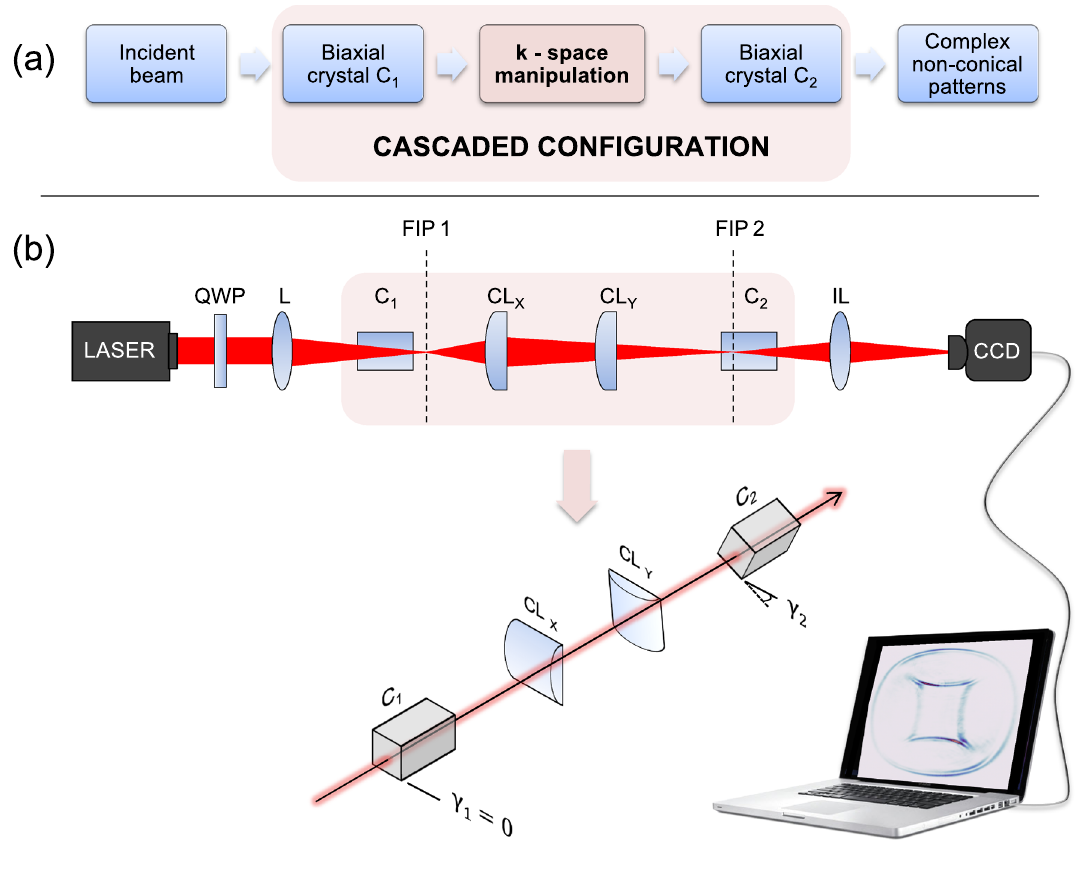
Figure 1. ( a ) Schematic concept for generating non-circularly shaped conical diffraction beams. ( b ) Optical setup; QWP: quarter-wave plate, L: focusing lens, C 1 /C 2 : biaxial crystals, CL x /CL y : crossed cylindrical lenses, FIP1/FIP2: focal image planes, IL: imaging lens of FIP2 onto CCD camera. The angle γ 2 is the rotation angle of crystal C 2 with respect to C 1 around the common optical